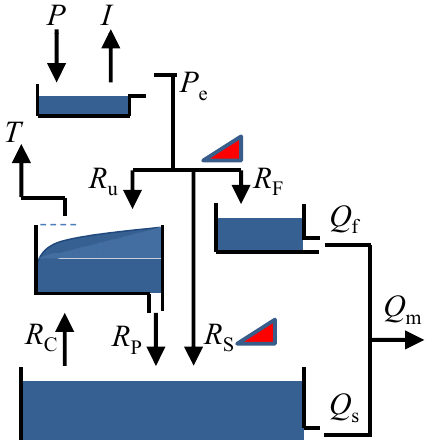
Figure 4. The models structure of FLEX A . Precipitation is indi- cated by P ; I and T represent components of evaporation which are interception and transpiration respectively. Q f and Q s indicate the fast and slow components that make the total model output ( Q m ). The water balance equations and constitutive functions are presented in the companion paper (Gharari et al.,